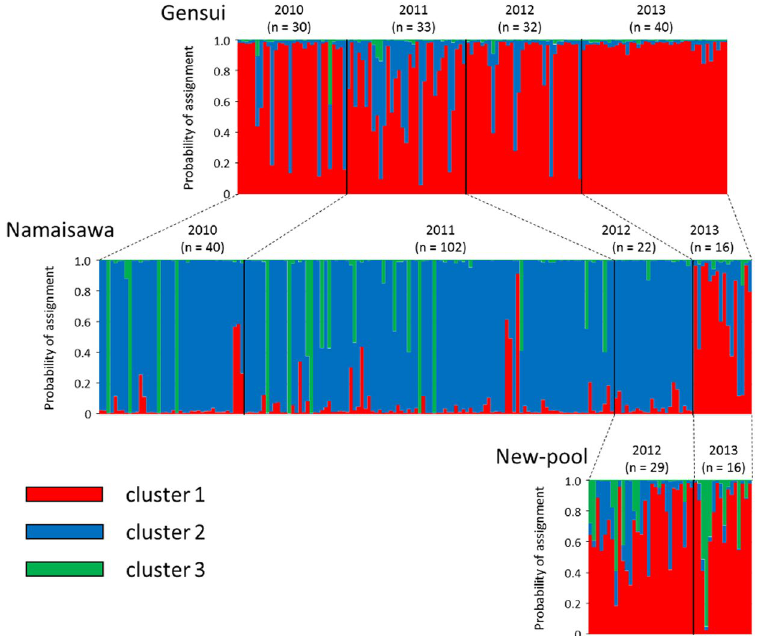
Figure 6. Genetic structure of threespine sticklebacks collected from Otsuchi during 2010–2013. The probability of assignment to each genetic cluster estimated by STRUCTURE with K = 3 (see also Supplementary Fig. S4). n indicates the sample size. Specimens in 2010 were collected before the tsunami, whereas those in 2011–2013 were collected after the